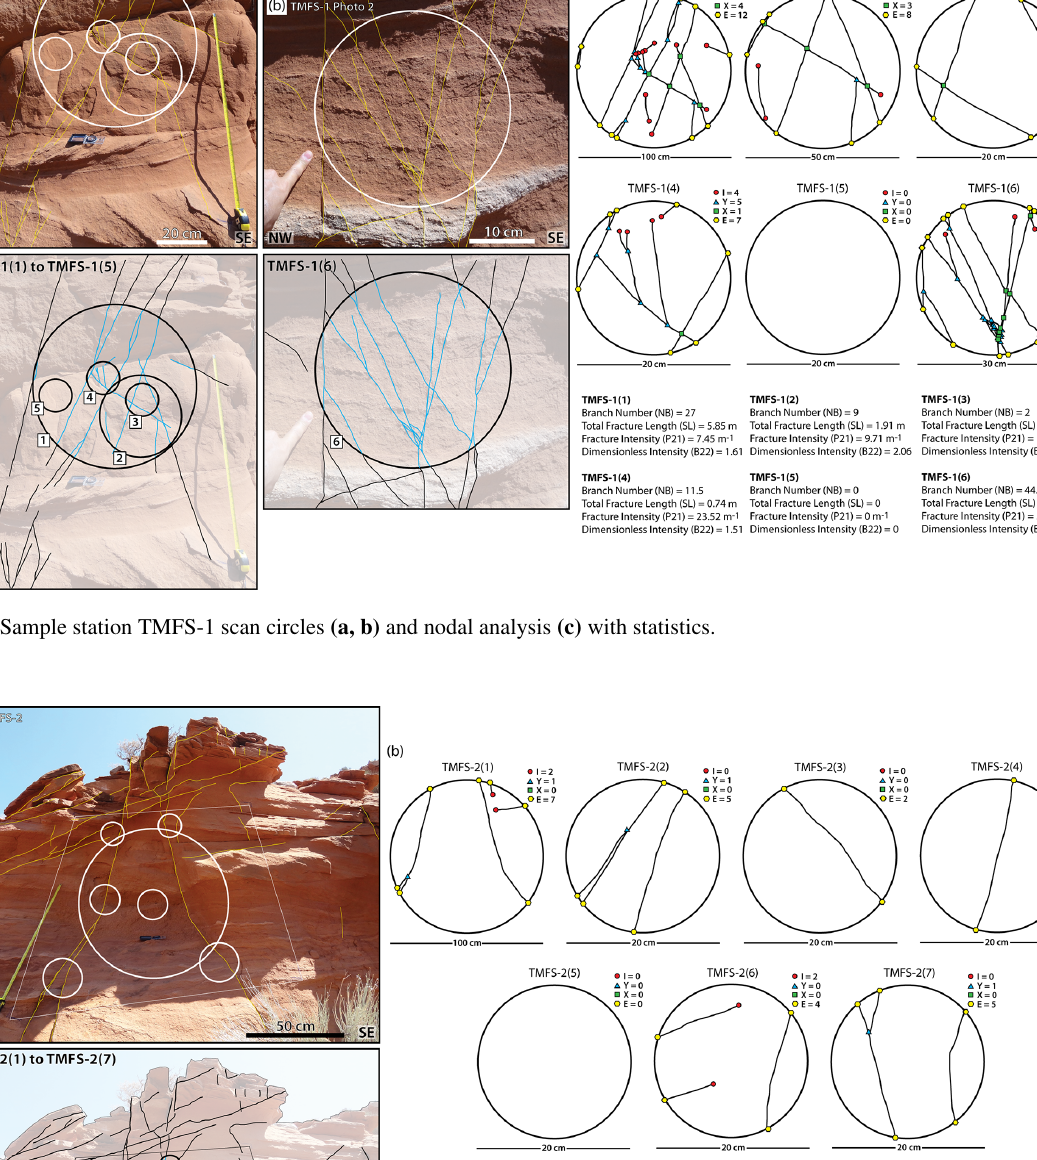
https://doi.org/10.5194/se-12-95-2021 Solid Earth, 12, 95–117,